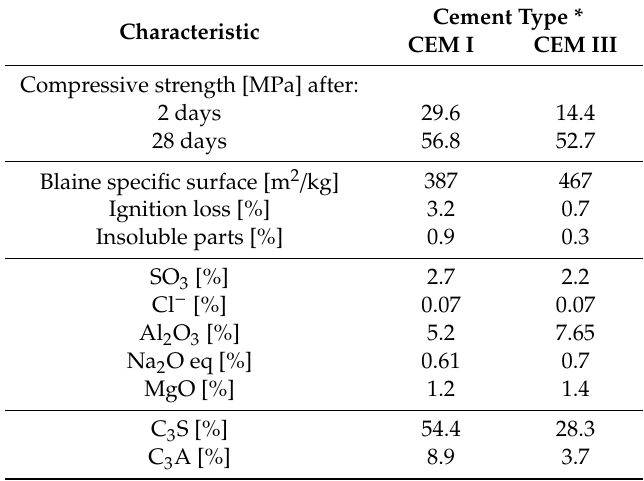
Table 1. Characteristics of cements used for recycled aggregate concrete (RAC).